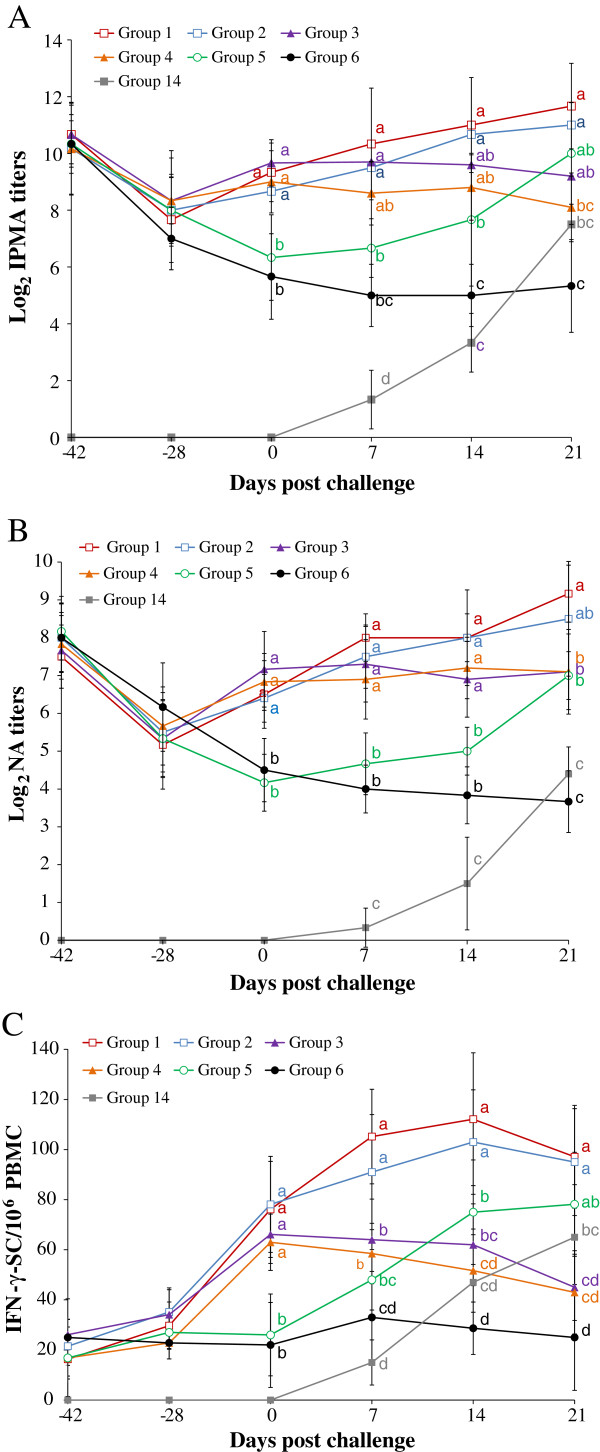
PCV2b-specific humoral and cell-mediated immune responses. Log2 transformed group means for PCV2b-specific immunoperoxidase monolayer assay (IPMA) titers (A), neutralizing antibody (NA) titers (B), and frequency of PCV2b-specific interferon-γ-secreting cells (IFN-γ-SC)/106 peripheral blood mononuclear cells (PBMC) (C) from 7 different groups (commercial inactivated chimeric PCV1-2 vaccinated PCV2b-challenged PCV2a-viremic pigs (group 1), experimental inactivated PCV2 vaccinated PCV2b-challenged PCV2a-viremic pigs (group 2), commercial inactivated chimeric PCV1-2 vaccinated unchallenged PCV2a-viremic pigs (group 3), experimental inactivated PCV2 vaccinated unchallenged PCV2a-viremic pigs (group 4), unvaccinated PCV2b-challenged PCV2a-viremic pigs (group 5), unvaccinated unchallenged PCV2a-viremic pigs (group 6), and unvaccinated PCV2b-challenged non-PCV2-viremic pigs (group 14)). Different letters (a, b, c, and d) indicate statistically significant differences (P < 0.05) among groups.